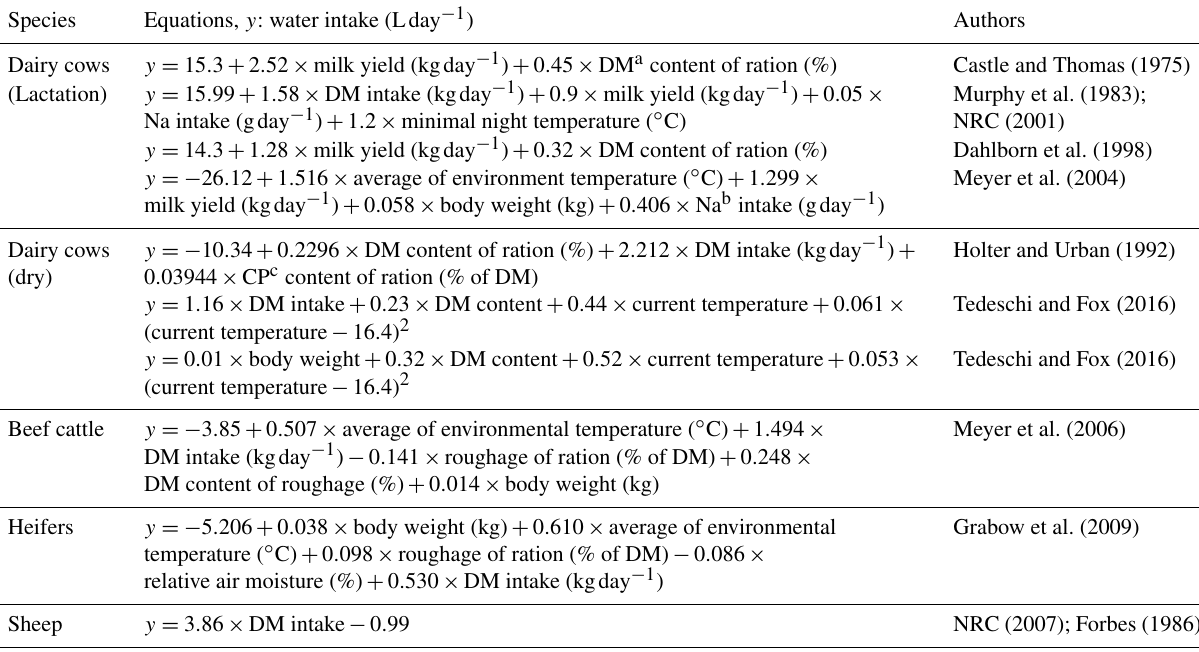
Table 6. Some equations to predict the water intake of ruminants depending on various influencing factors by several authors.